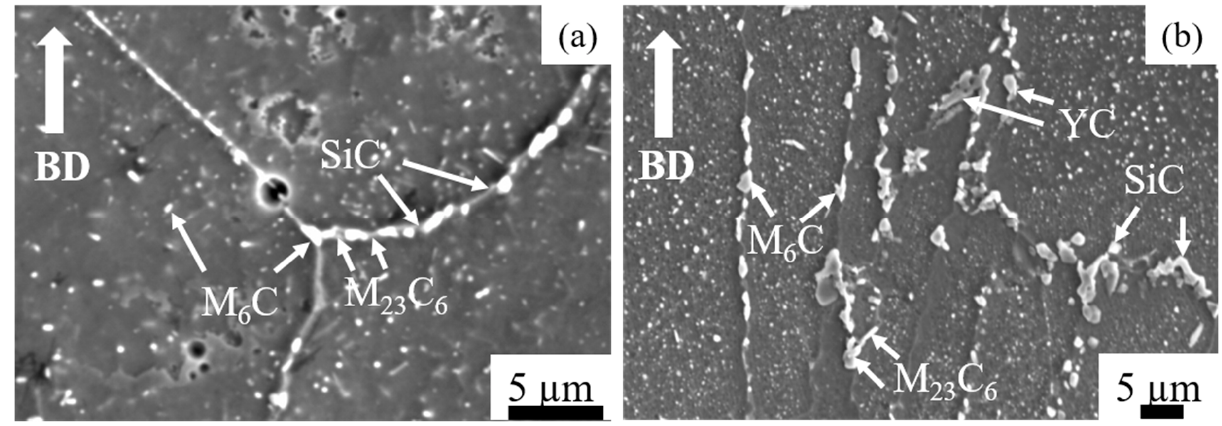
Figure 14. SEM micrographs of the carbides after creep test at 900 °C/80 MPa: ( a ) HX ST and ( b ) HX-a ST.